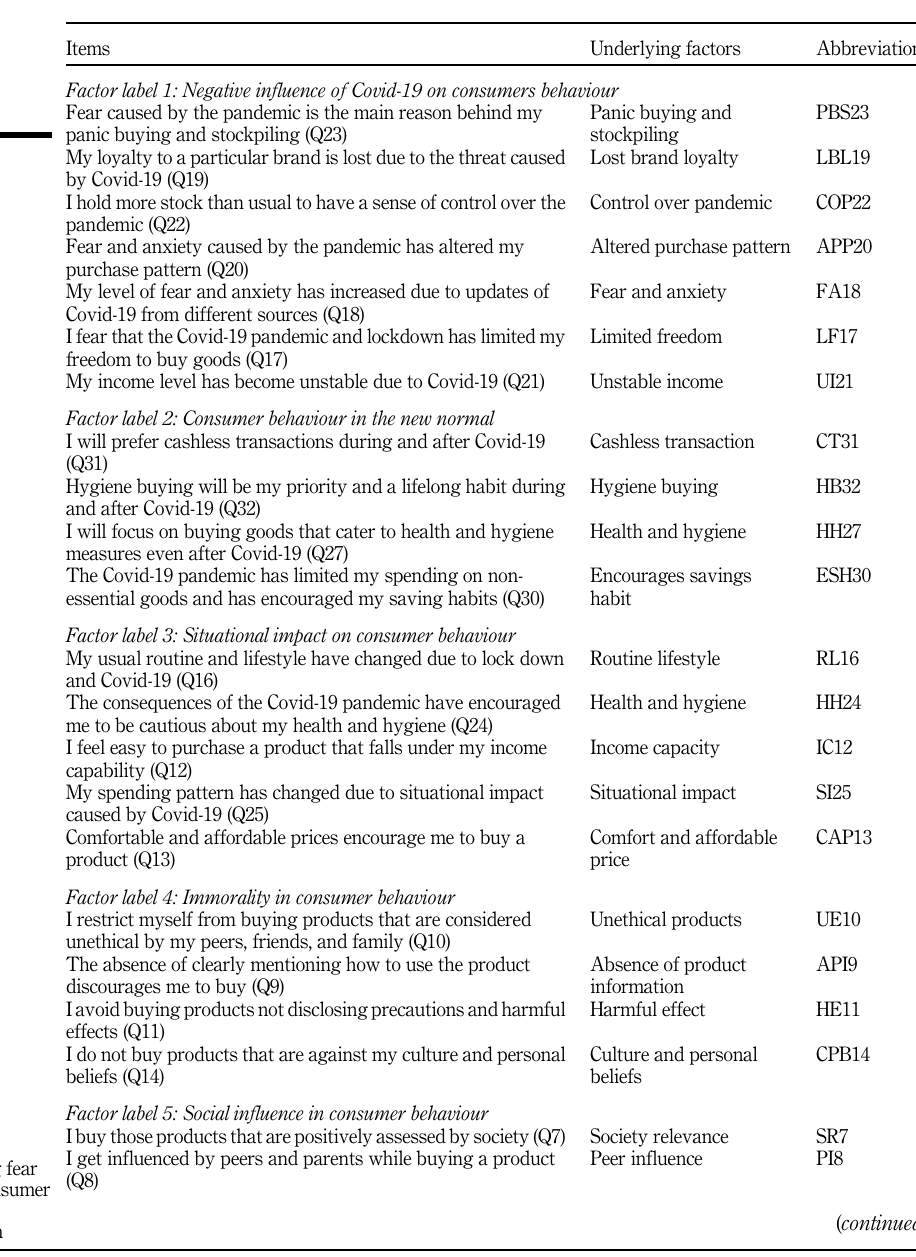
Table A1. Covid-19 driving fear and greed in consumer behaviour and purchase